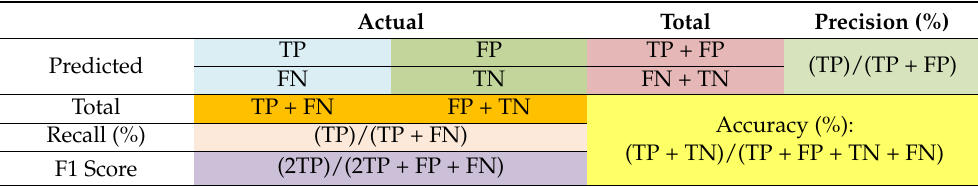
Table 2. Formulas for the evaluation criteria of the proposed classifier, including precision (%), recall (%), accuracy (%), and F1 score.